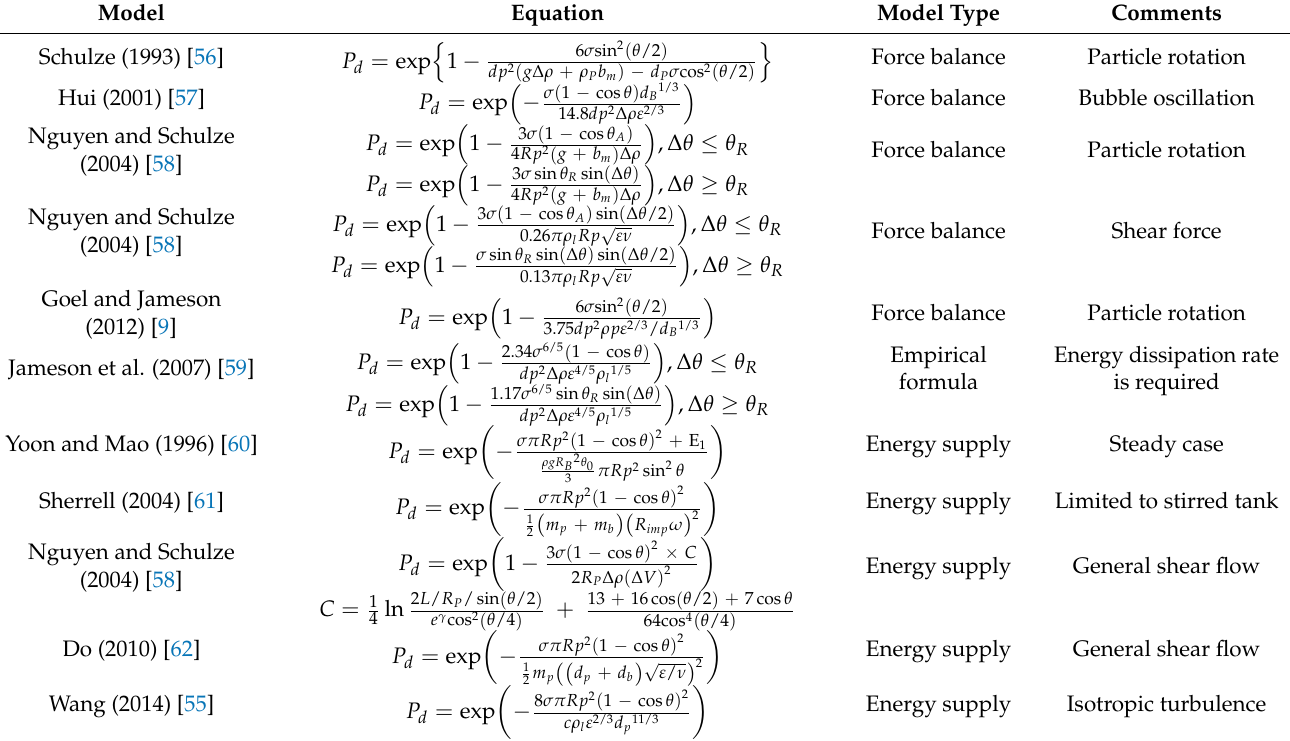
Table 1. Exponential distribution function to describe particle detachment